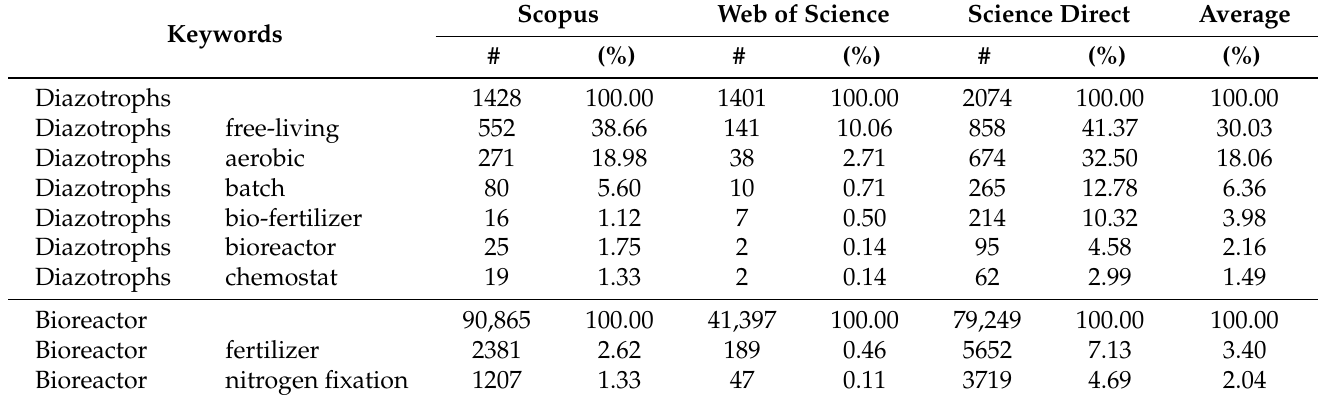
Table 1. Bibliometric data (4 July